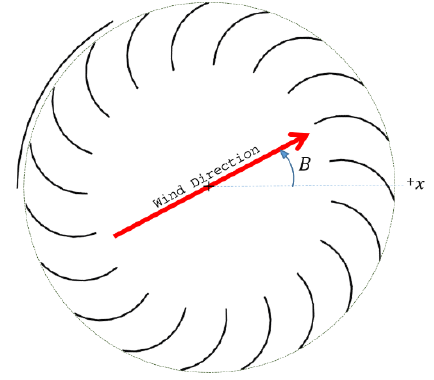
Figure 8. Reference for angles B and β i